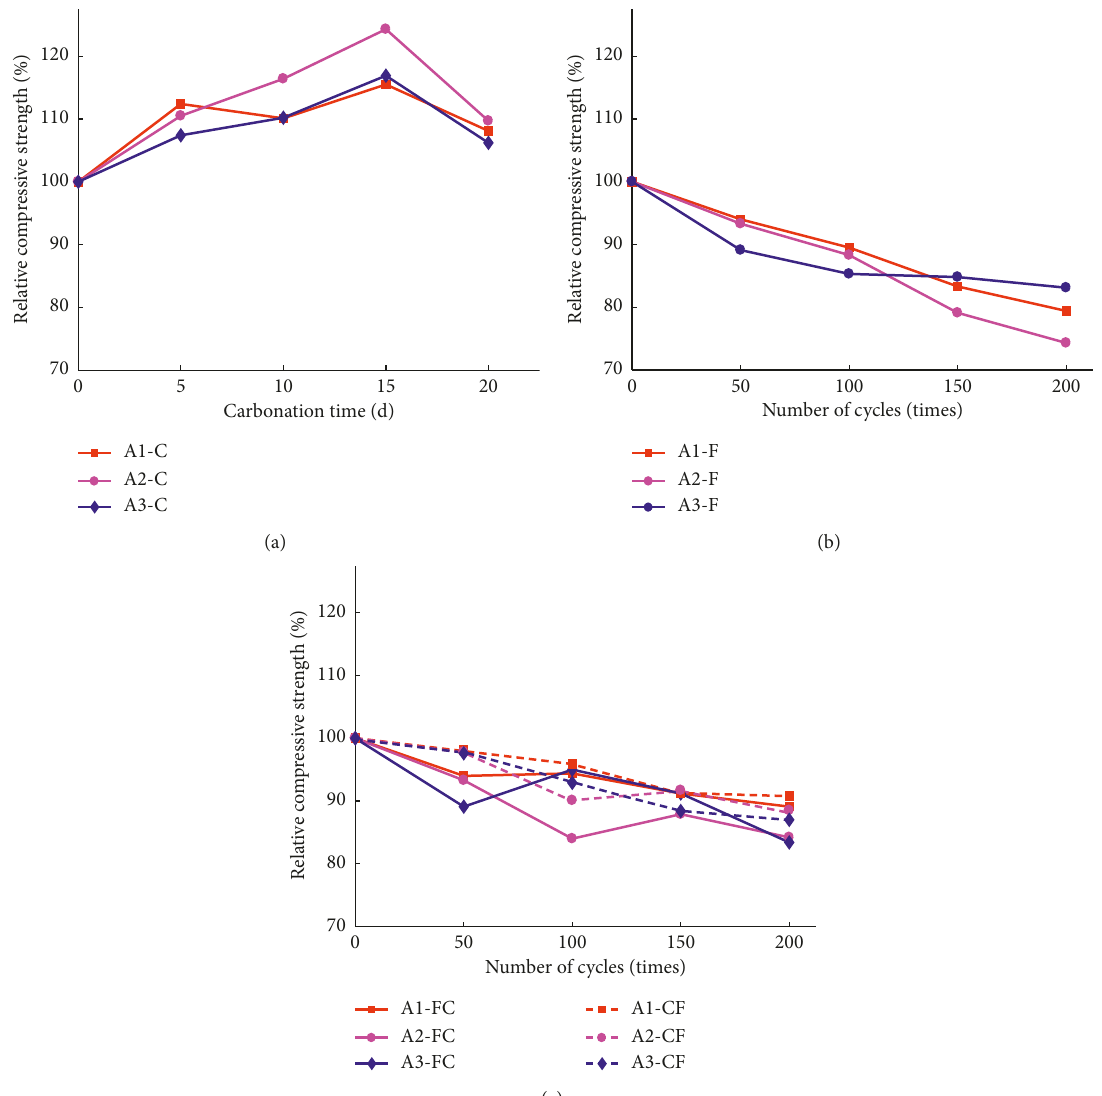
Figure 9: Relative compressive strengths of A1, A2, and A3 with different testing modes: (a) C mode; (b) F mode; (c) FC and CF